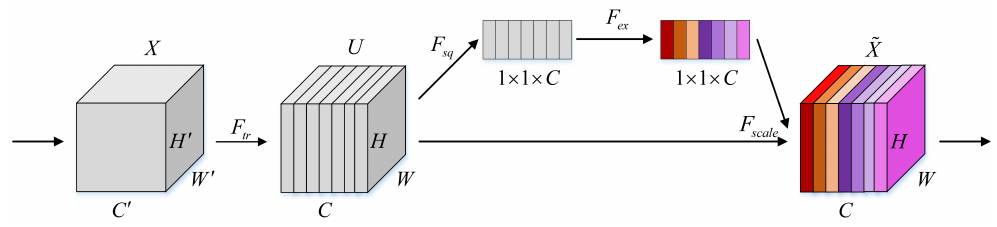
Figure 23. A Squeeze-and-Excitation (SE)